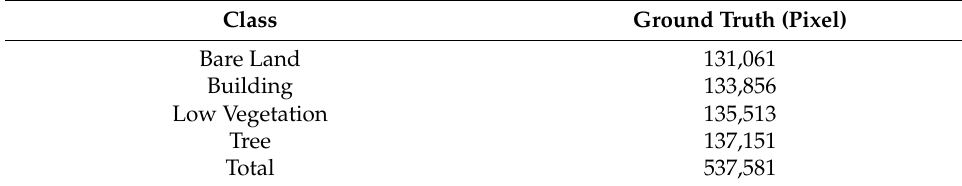
Table 3. Ground truths of the UH dataset.